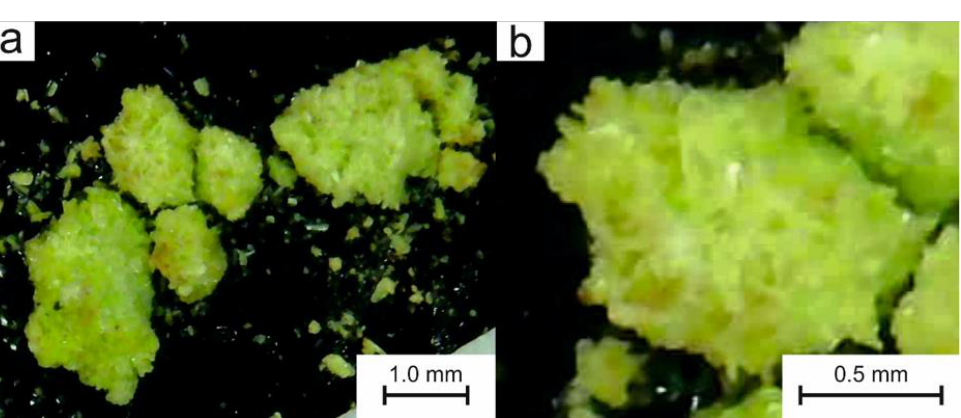
Figure 2. Optical photomicrographs of johannite fragments from sample NMW 67.154GR.69: ( a ) typical fragments of loosely aggregated and finely crystalline green to pale yellow-green johannite, with localised races of staining by orange-brown iron oxyhydroxide; and ( b ) detail of a johannite fragment showing a mass of fine, lath-like crystals with a vitreous lustre.